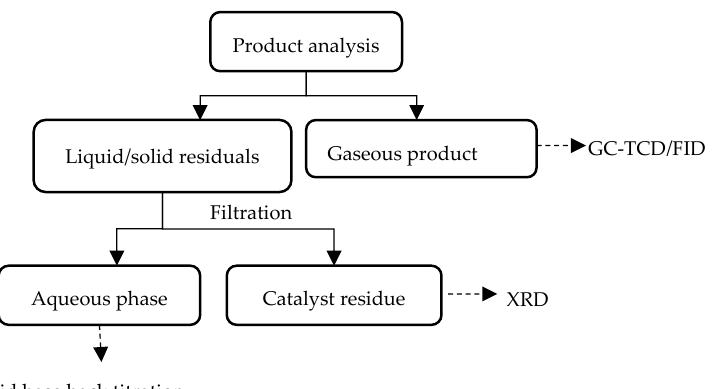
Figure 1. Product analysis scheme (XRD: x-ray diffractometer; GC/TCD/FID: gas chromatograph fitted with thermal conductivity detector and flame ionisation detector)